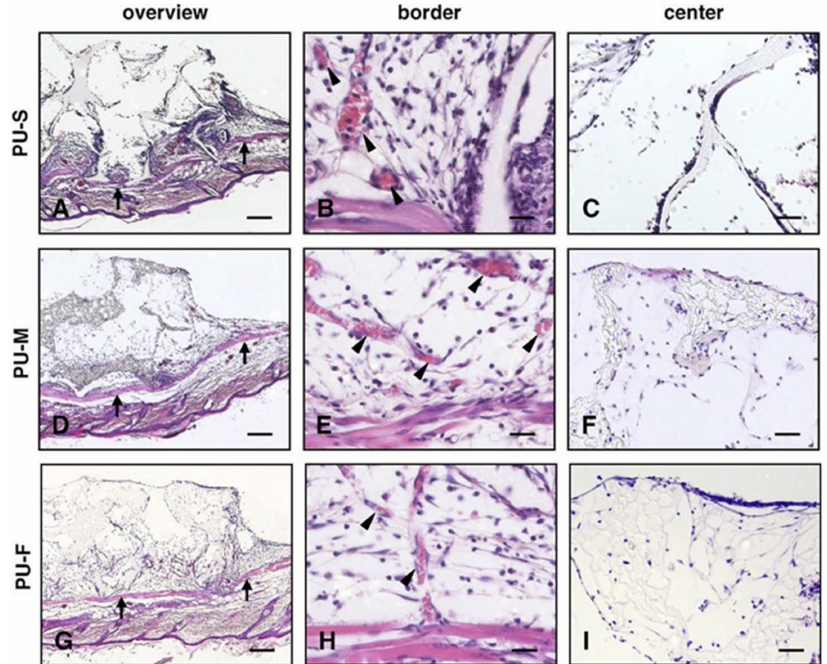
Figure 5. H&E-stained cross-sections of the PU-S ( A – C ), the PU-M ( D – F ) and the PU-F ( G – I ) scaffold at day 14 after implantation onto the striated muscle tissue ( A , D , G , arrows) of the dorsal skinfold chamber. Higher magnification of the basis of the scaffolds ( B , E , H ) shows a newly formed granulation tissue in the border zone growing into the pores of the scaffolds. Within this granulation tissue, newly formed blood vessels (arrowheads) can be observed. In contrast, the centre of the scaffolds ( C , F , I ) is still avascular with only a few single cells migrating along the polyurethane strands. Scale bars: A, D and G = 220 lm; B, C and E = 25 lm; F, H and I = 55 lm. Reprinted from [102] with permission from